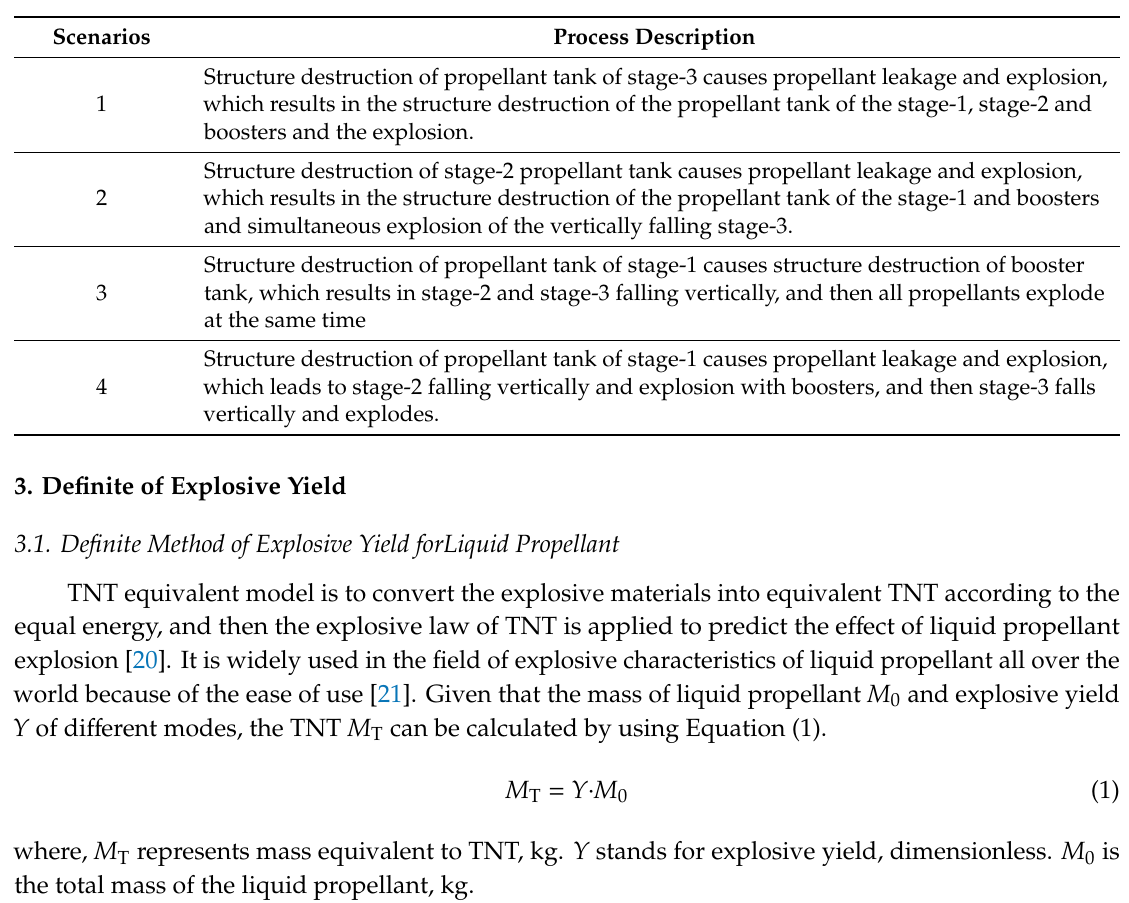
Table 2. Scenarios setting of the rocket explosion on launch